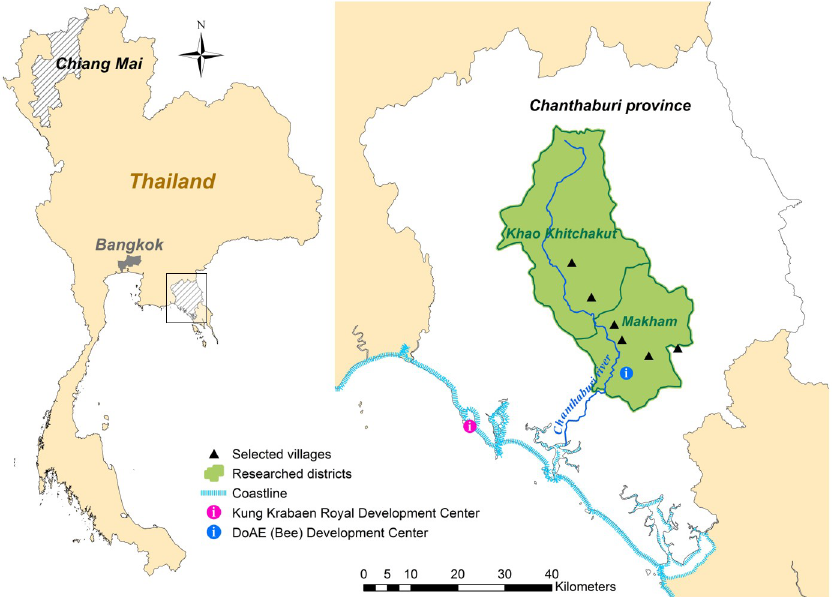
Fig 1. Research area in Chanthaburi. Source: Own representation using vector data from the DCW (Digital Chart of the World) and GADM (Global Administrative Areas) databases made available by DIVA-GIS [55].